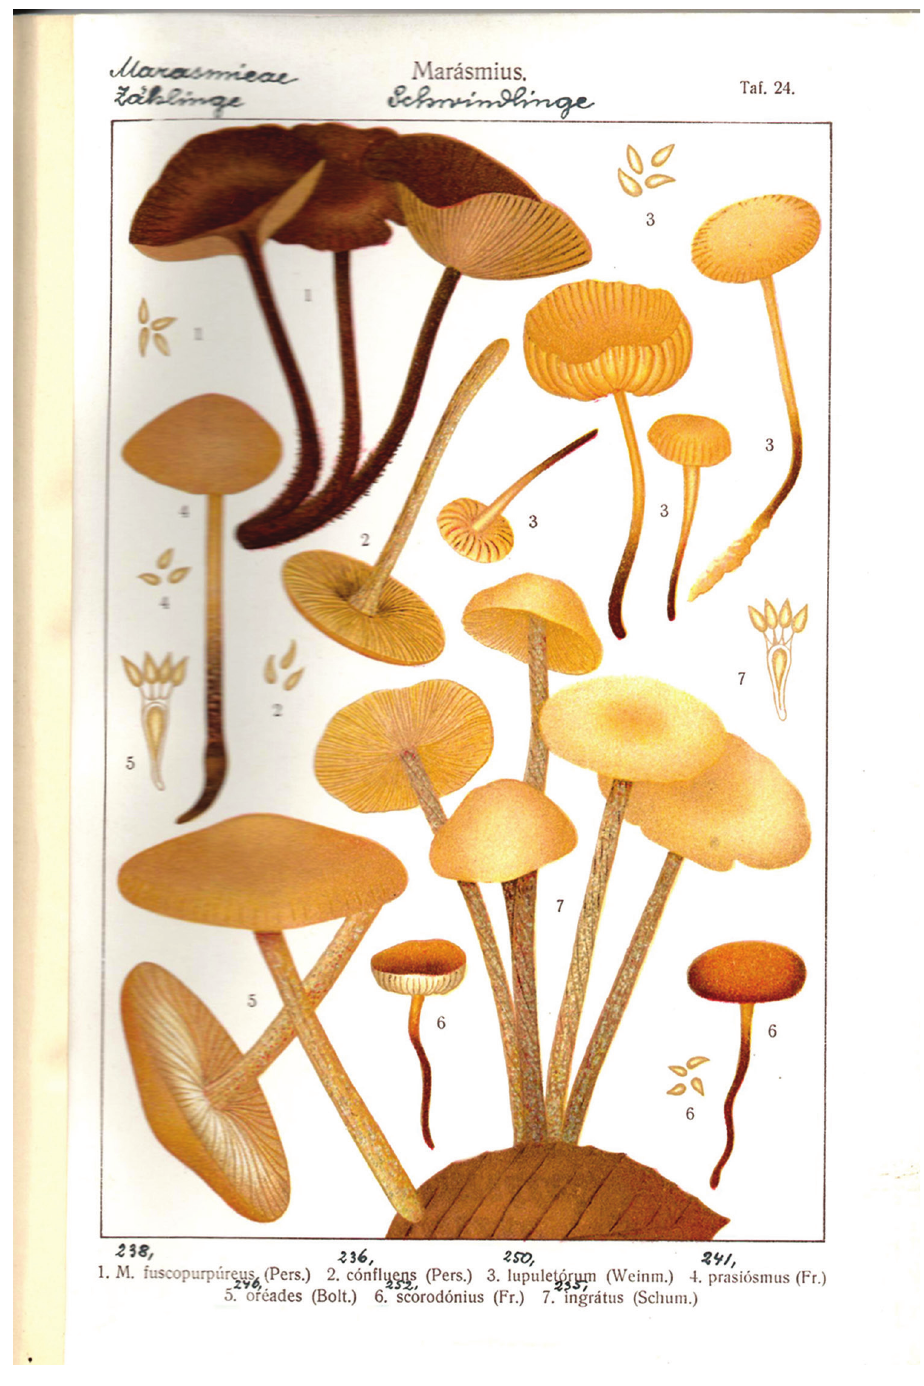
Figure 101. Ricken’s plate including M. prasiosmus